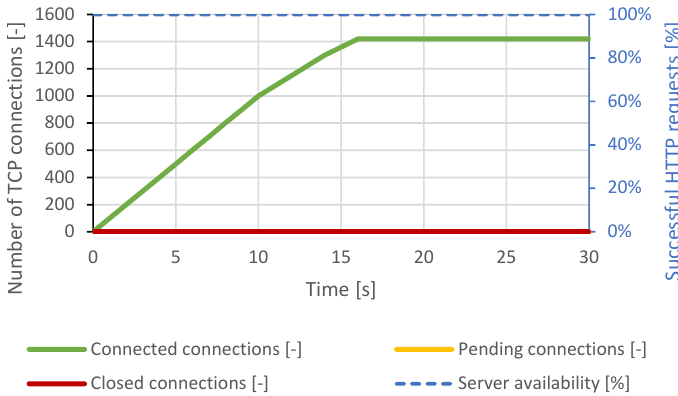
Figure 18. SlowDrop attack against IIS server.